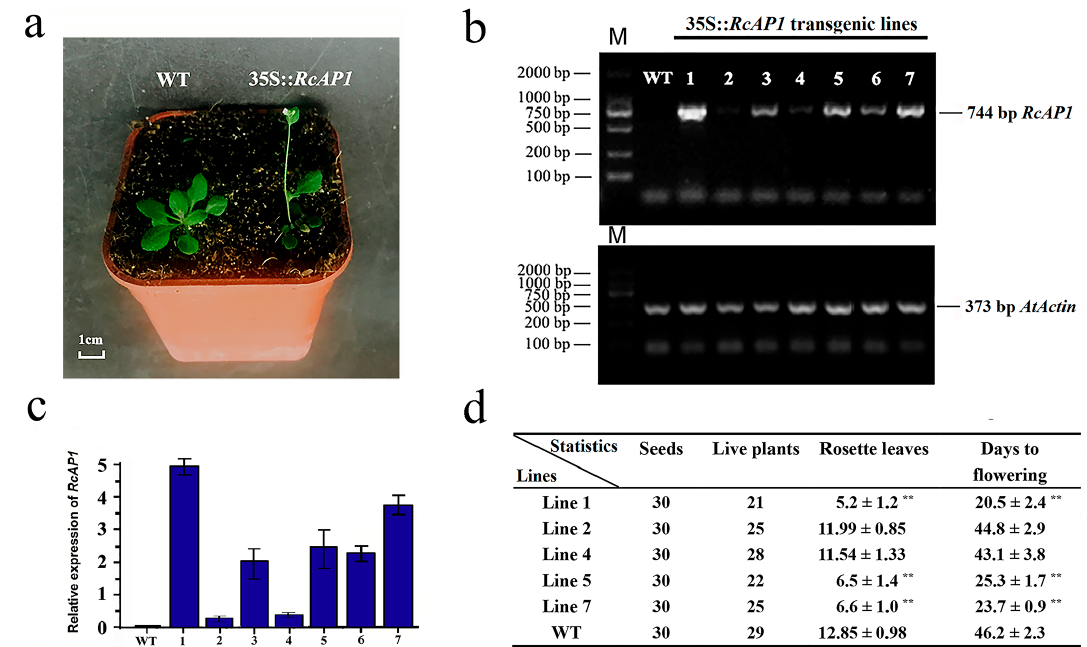
Figure 6. Overexpression of RcAP1 induces early flowering in transgenic A. thaliana plants. ( a ) Representative 35S:: RcAP1 transgenic plant exhibiting early flowering under long-day conditions. Bar, 1 cm. ( b ) Results of an RT-PCR analysis of RcAP1 expression in transgenic A. thaliana plants. M,